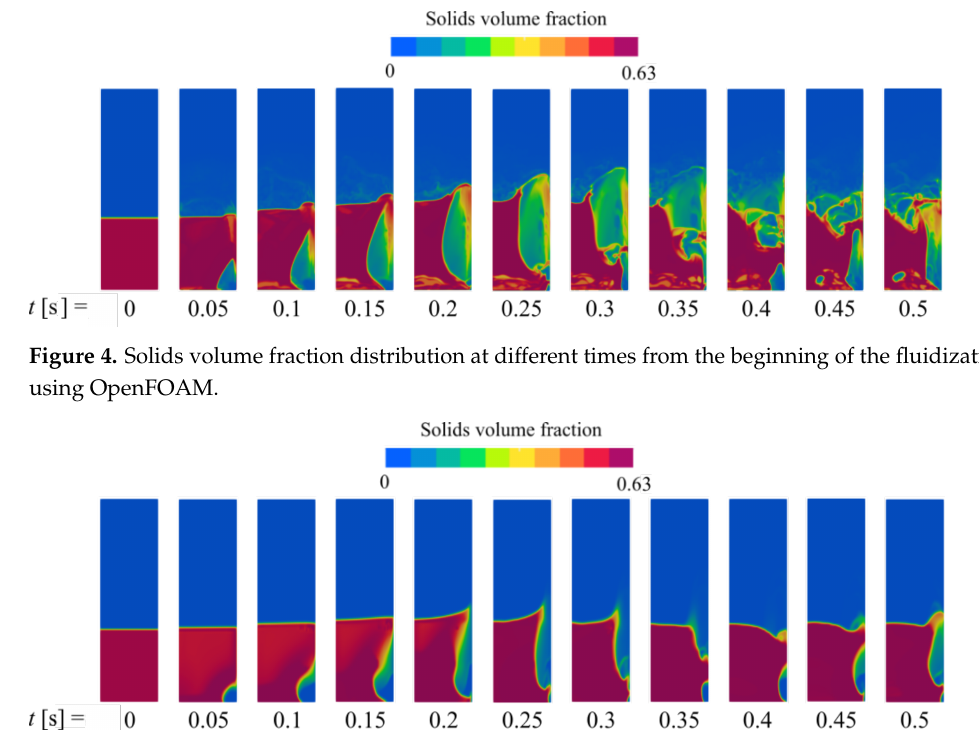
Figure 5. Solids volume fraction distribution at different times from the beginning of the fluidization using